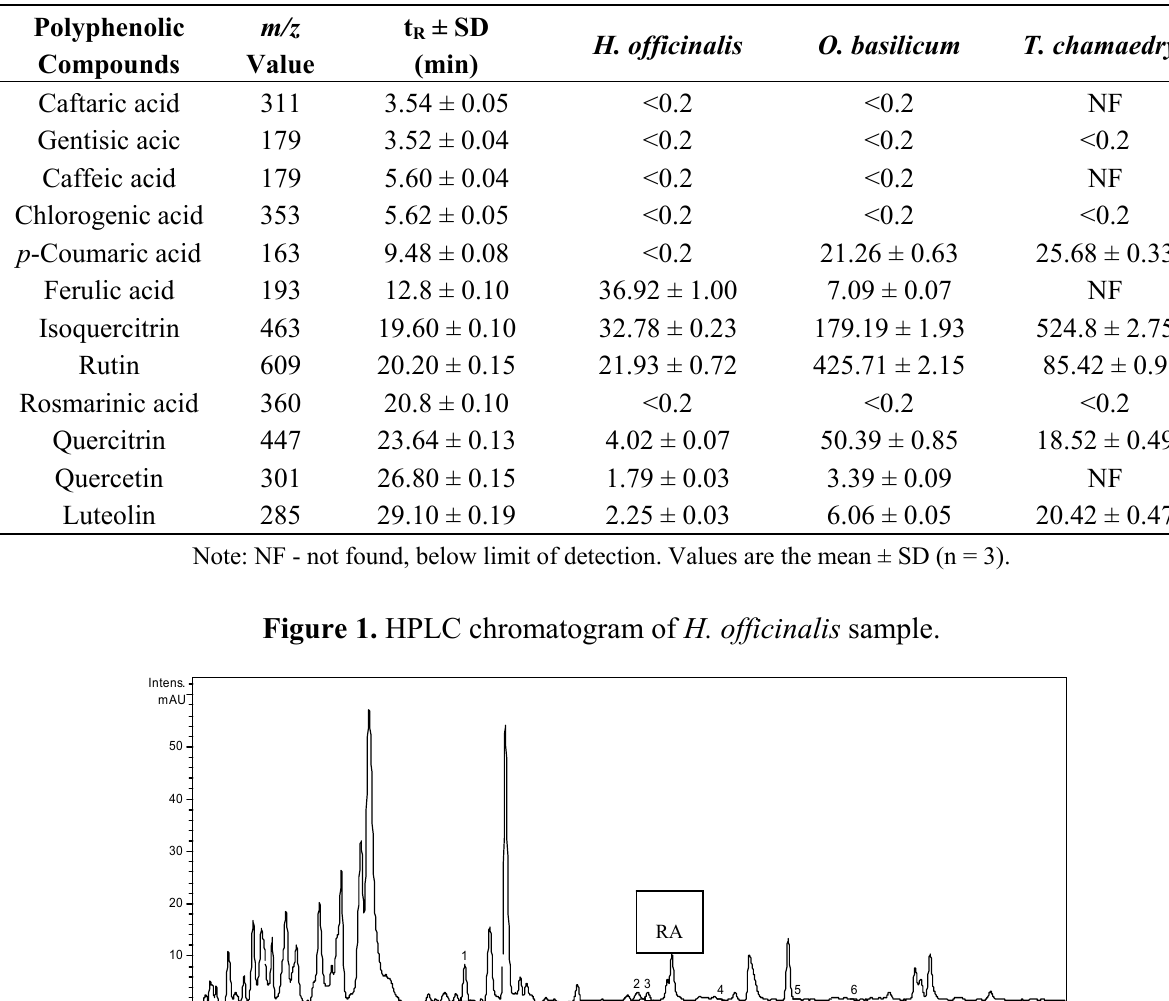
Table 1. The polyphenolic compounds content in the studied species (µg/g plant material).